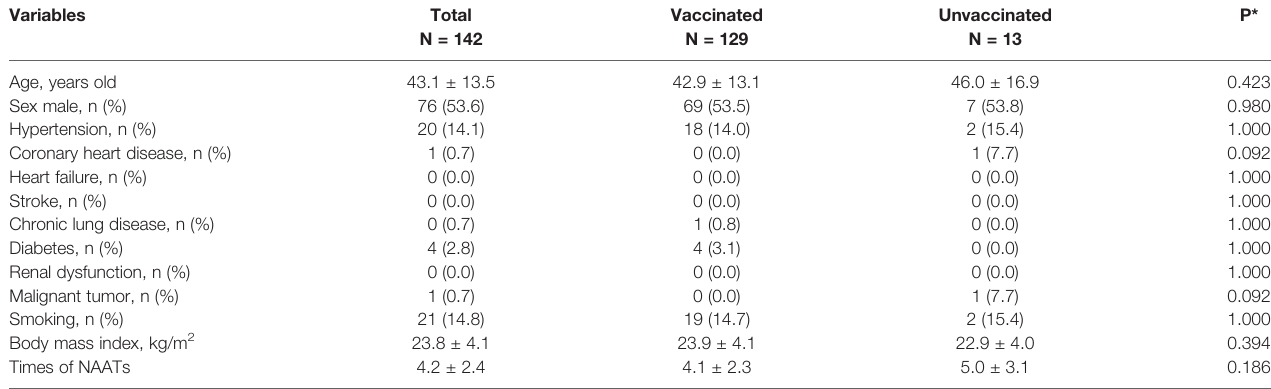
TABLE 1 | Patient characteristics.